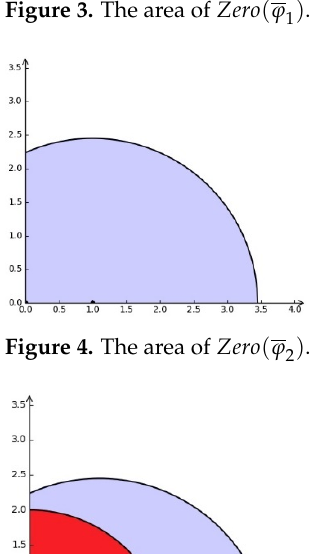
Figure 3. The area of Zero ( ϕ